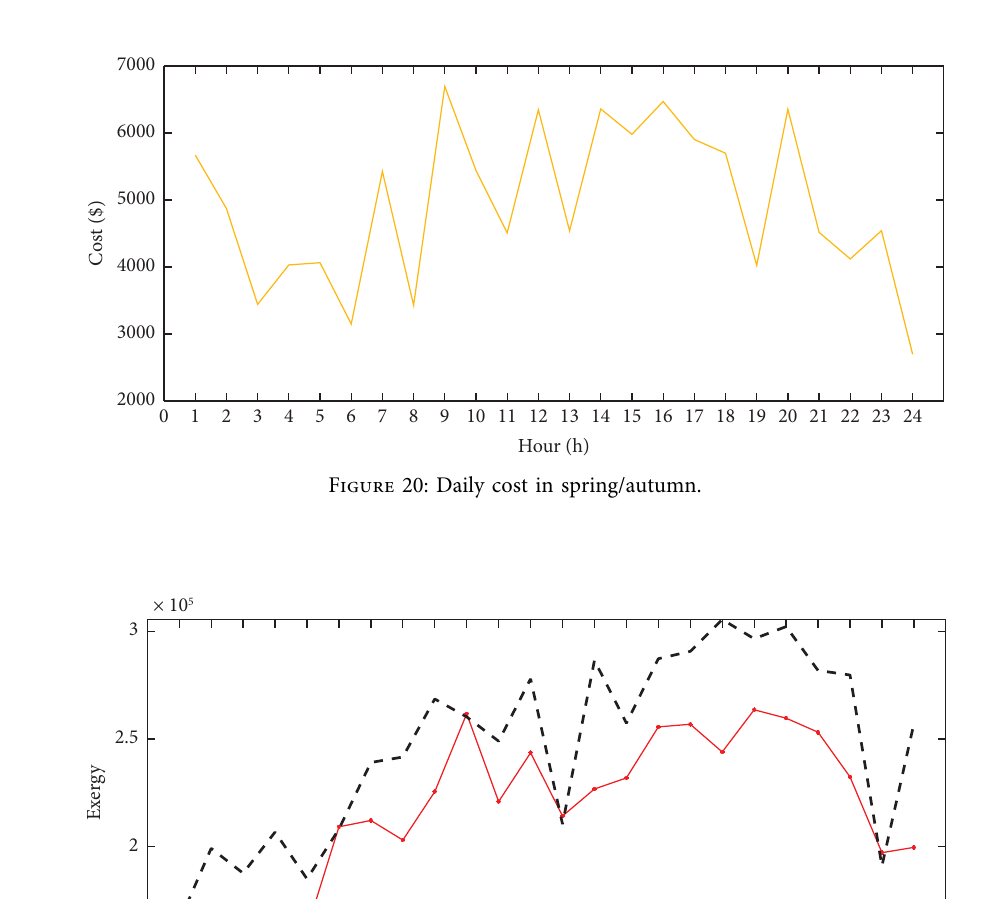
Figure 19: Daily cost of typical day in winter.